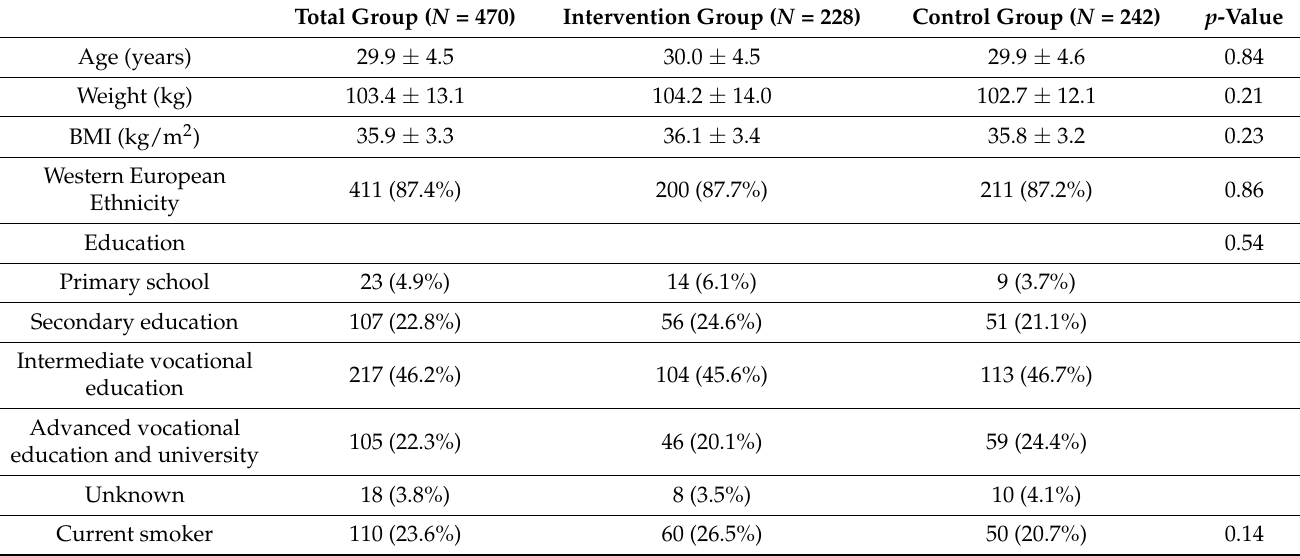
Table 1. Baseline characteristics of subjects who had at least one serum FT measurement at baseline, at three months or at six months after